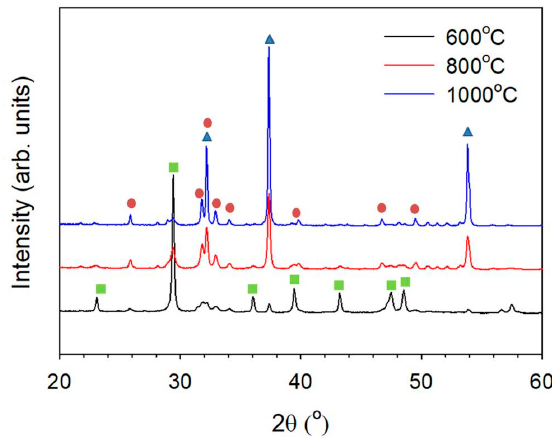
Figure 1. XRD pattern of the fibers calcined at different temperatures under an air atmosphere.